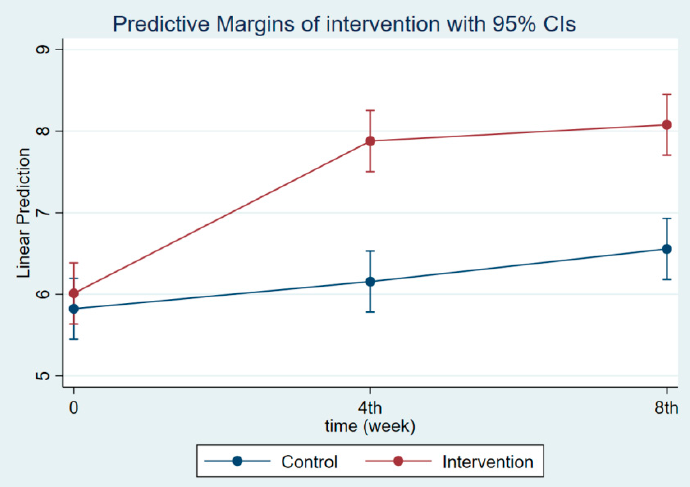
Figure 2. Maternal knowledge regarding CGM at follow-ups 1 and 2.